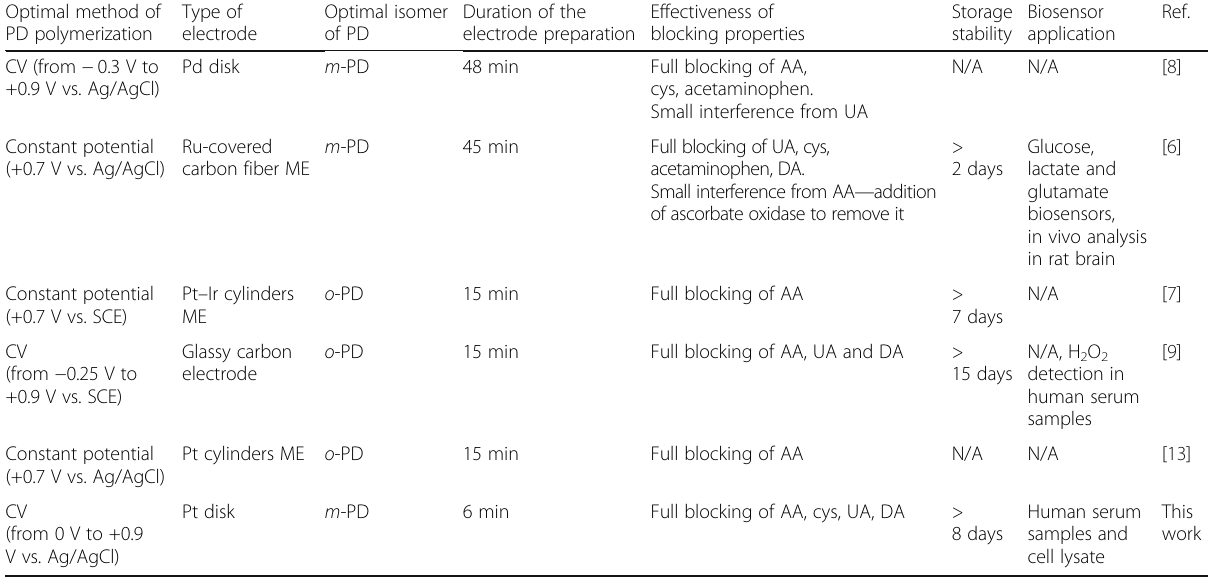
Table 4 Comparison of the developed method of deposition of PPD membrane with previously reported methods Optimal method of PD